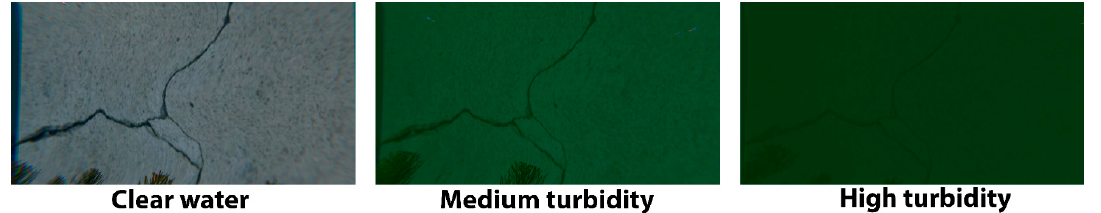
Figure 12. Images of a cracked surface on a wharf captured under clear, medium turbidity, and high turbidity conditions.